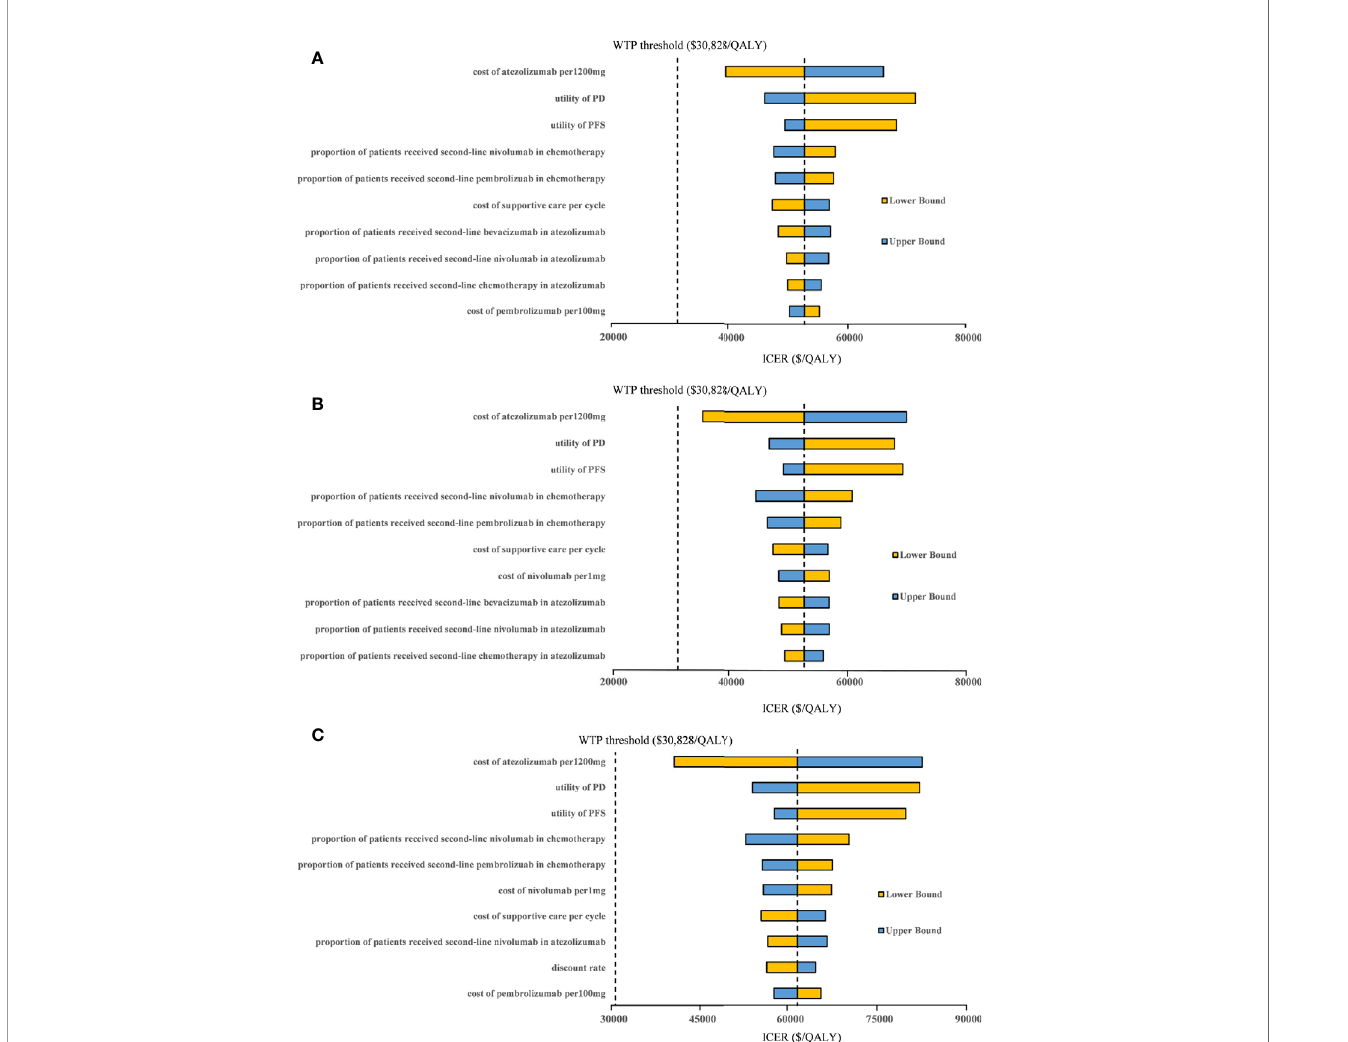
FIGURE 4 | Tornado diagram of one-way sensitivity analyses with greatest in fl uence parameters when the PAP was available in (A) high PD-L1 expression populations, (B) high or intermediate PD-L1 expression populations and (C) any PD-L1 expression populations. PD-L1, programmed death ligand 1; PFS, progression-free survival; PD, progressed disease; WTP, willingness-to-pay; ICER, incremental cost-effectiveness